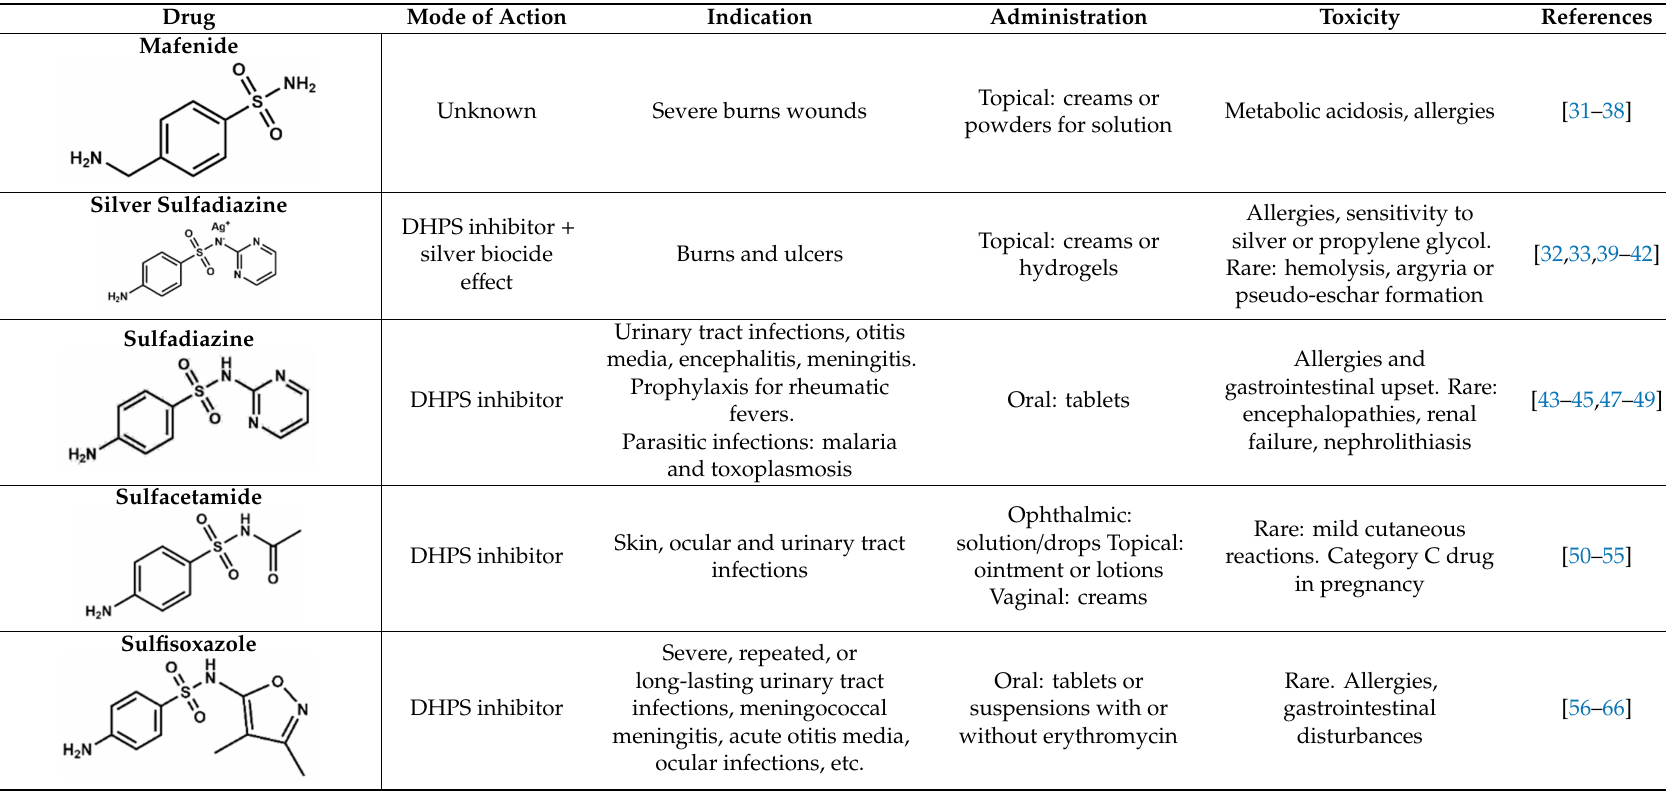
Table 1. Summary of the reviewed antifolates as antibiotic agents, including their modes of action, indications, mode of administration and toxicity